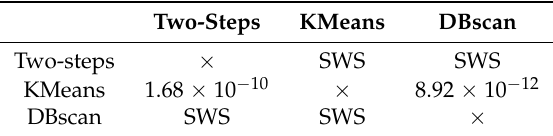
Table 19. p -values for instance f.1.